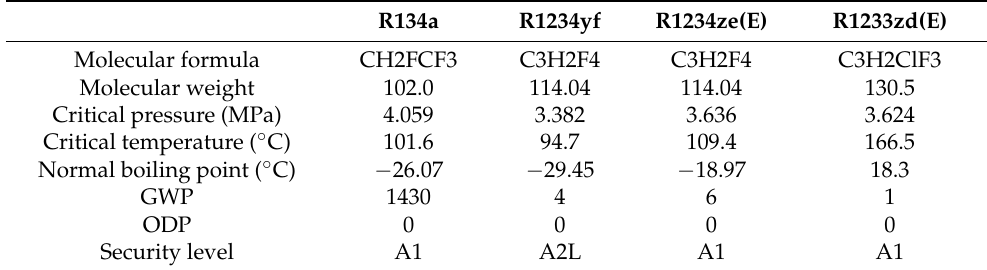
The saturation lines of four refrigerants on the pressure-specific enthalpy diagram are shown as thin lines in Figure 1a. It can be seen that the saturation lines of R1234ze(E) and R1234yf are similar to that of R134a, and the saturation line of R1234ze(E) has the smallest deviation from that of R134a. The saturation line of R1233zd(E) is quite different from that of R134a. Under the same pressure, it has a relatively higher specific enthalpy value than R134a.